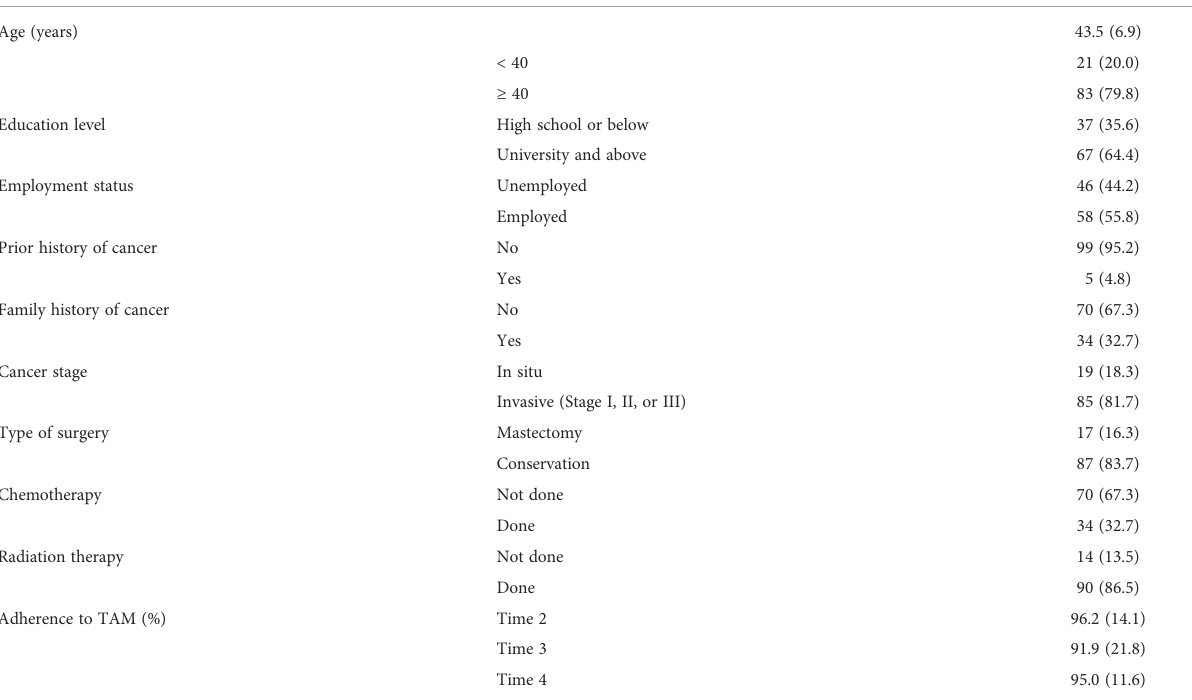
TABLE 1 Overview of participant